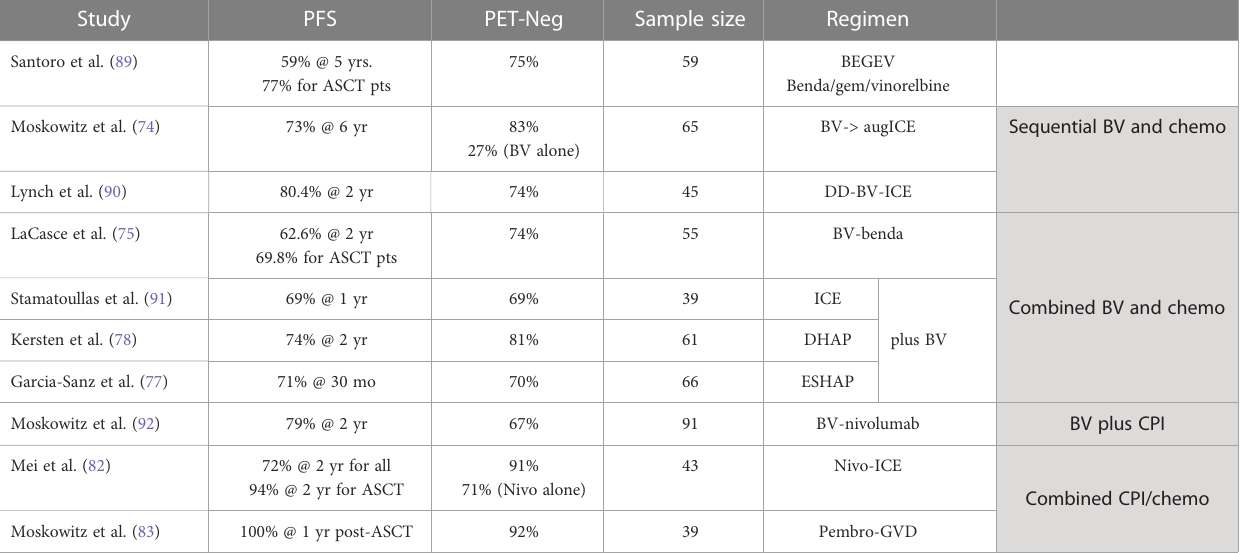
TABLE 2 Summary of immunotherapy in addition to chemotherapy in the salvage